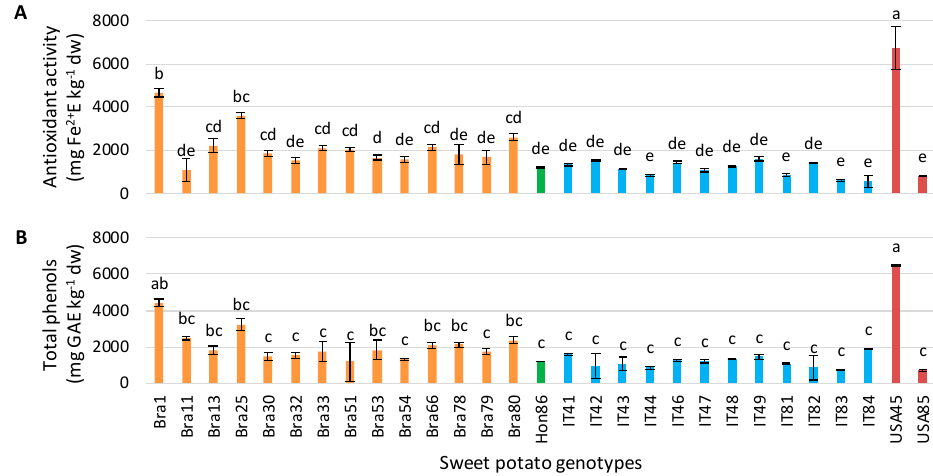
Figure 1. Total phenols content and total antioxidant activity of sweet potato genotypes. Histogram values without common letters significantly differed at p < 0.05 according to Tukey’s HSD test.